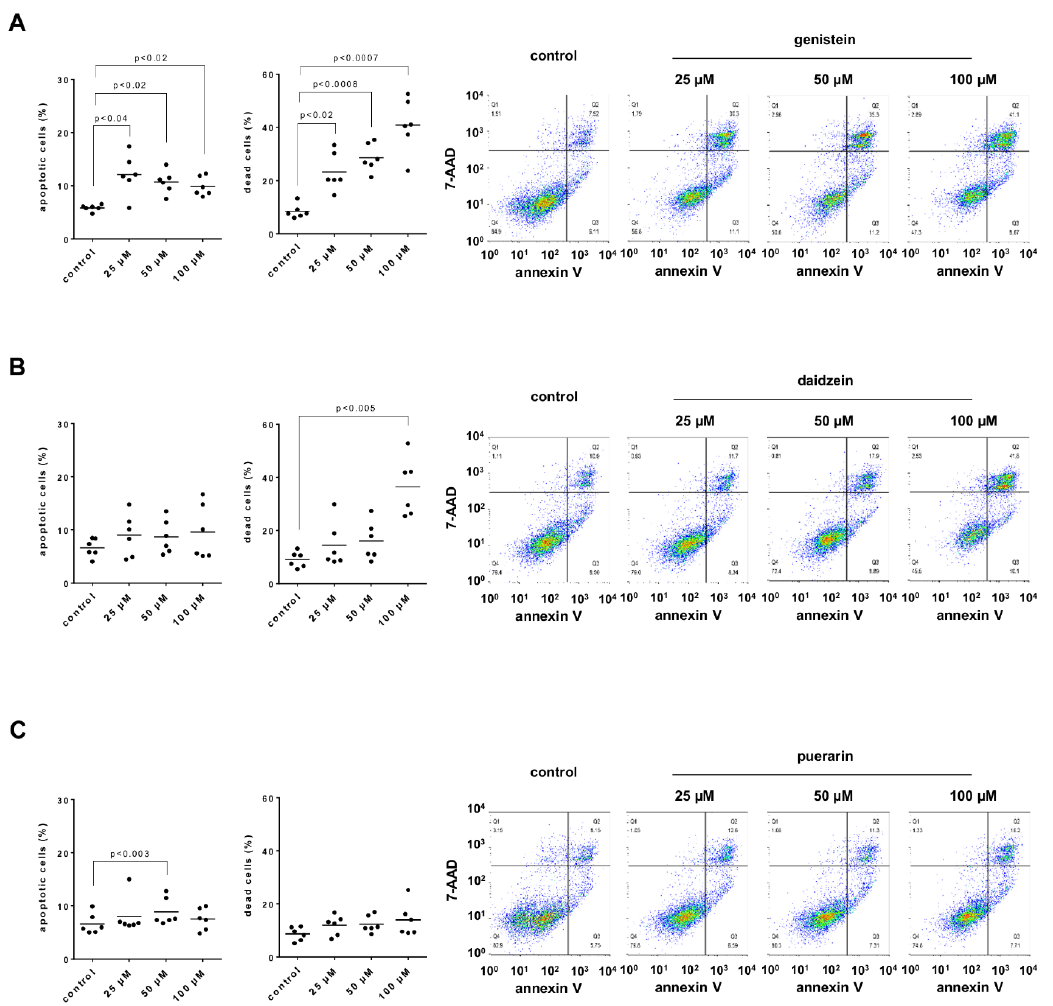
Figure 9. Effects of genistein, daidzein and puerarin on apoptosis and cell death in WPMY-1 cells. Numbers of cells in apoptosis (annexin V-positive, 7-AAD-negative) and of dead cells (resulting from apoptosis and/or necrosis; annexin V-positive, 7-AAD-positive) were assessed by flow cytometry. Flow cytometry was performed following culture with genistein ( A ), daidzein ( B ) and puerarin ( C ) at the indicated concentrations or solvent (DMSO for genistein and daidzein, methanol for puerarin) for the controls for 24 h. Shown are all single values together with means from the quantification of five independent experiments and representative experiments for each series, along with p -values from one-way ANOVA with Dunnett’s